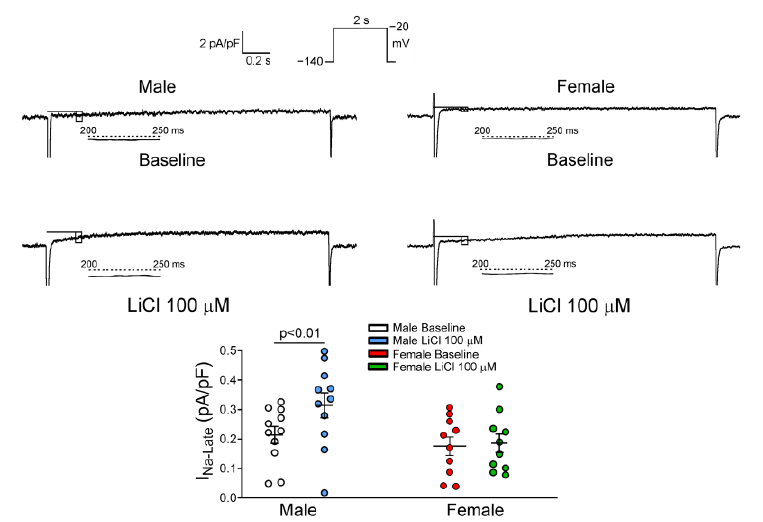
Figure 6. Effects of lithium on the late sodium current (I Na-late ) in right ventricular outflow tract (RVOT) cardiomyocytes. Representative tracings and the difference of peak current density of the I Na-late before and after lithium (100 µ M) administration in male ( n = 11) and female ( n = 10) RVOT cardiomyocytes. Lithium significantly increased I Na-late in male RVOT cardiomyocytes compared to female RVOT cardiomyocytes, LiCl = lithium chloride.